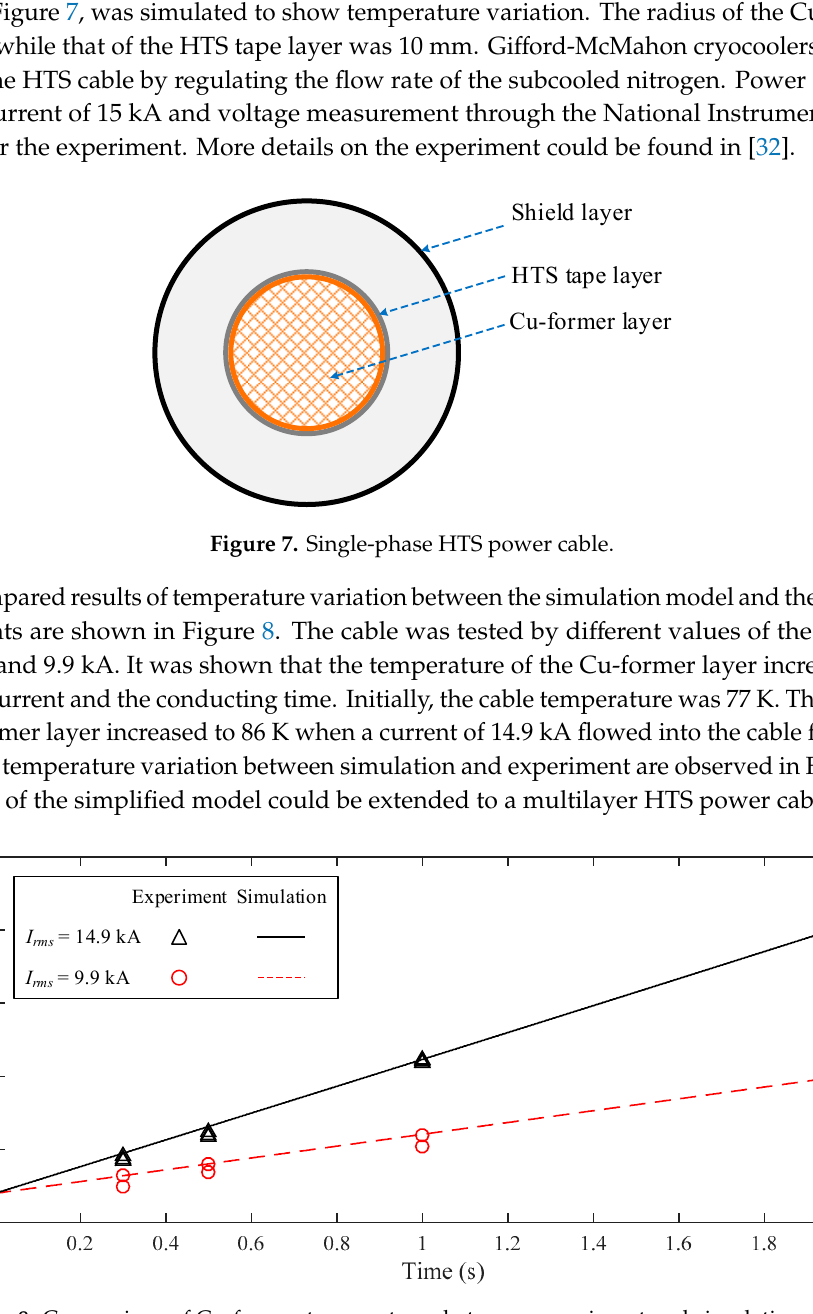
Figure 6. Cable modeling in PSCAD/EMTDC.